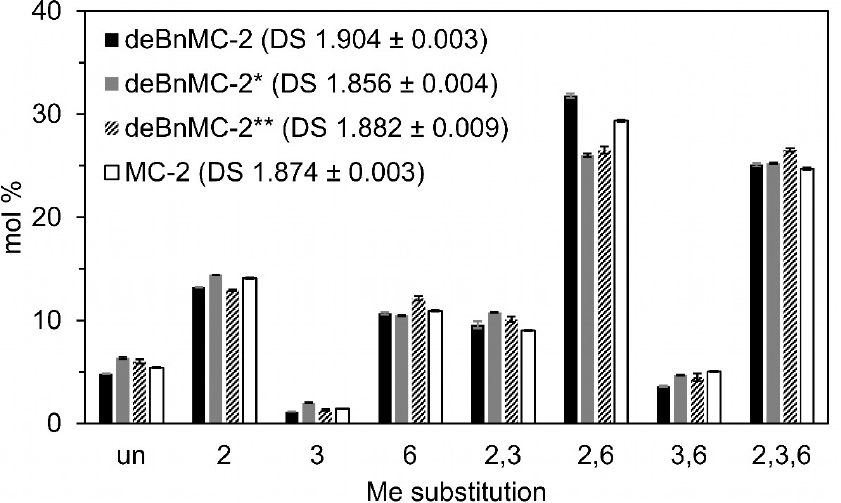
Figure 5. Methyl substitution pattern of deBnMC-2 (Method-1, Table 1), deBnMC-2* (Method-2a, Table 1), deBnMC-2** (Method-2b, Table 1), and MC-2 (for comparison) evaluated based on mono- mer analysis of alditol acetates by GLC-FID. For details refer to the Materials and Methods Section 2.6.1.